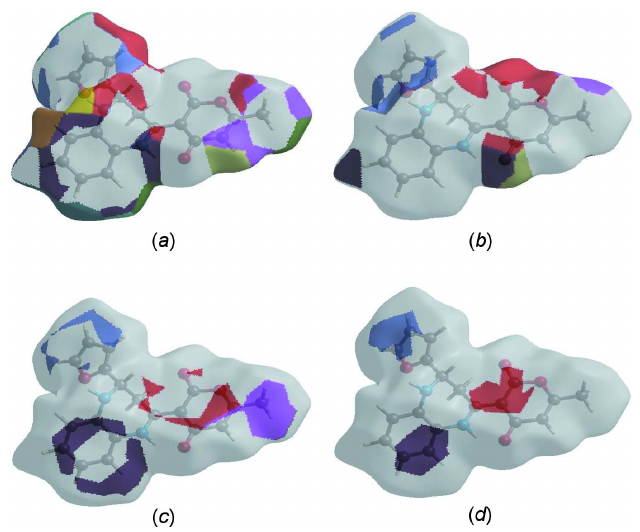
Figure 6 The Hirshfeld surface representations with the function d norm plotted onto the surface for ( a ) H (cid:3)(cid:3)(cid:3) H, ( b ) H (cid:3)(cid:3)(cid:3) O/O (cid:3)(cid:3)(cid:3) H, ( c ) H (cid:3)(cid:3)(cid:3) C/C (cid:3)(cid:3)(cid:3) H and ( d ) C (cid:3)(cid:3)(cid:3) C interactions.